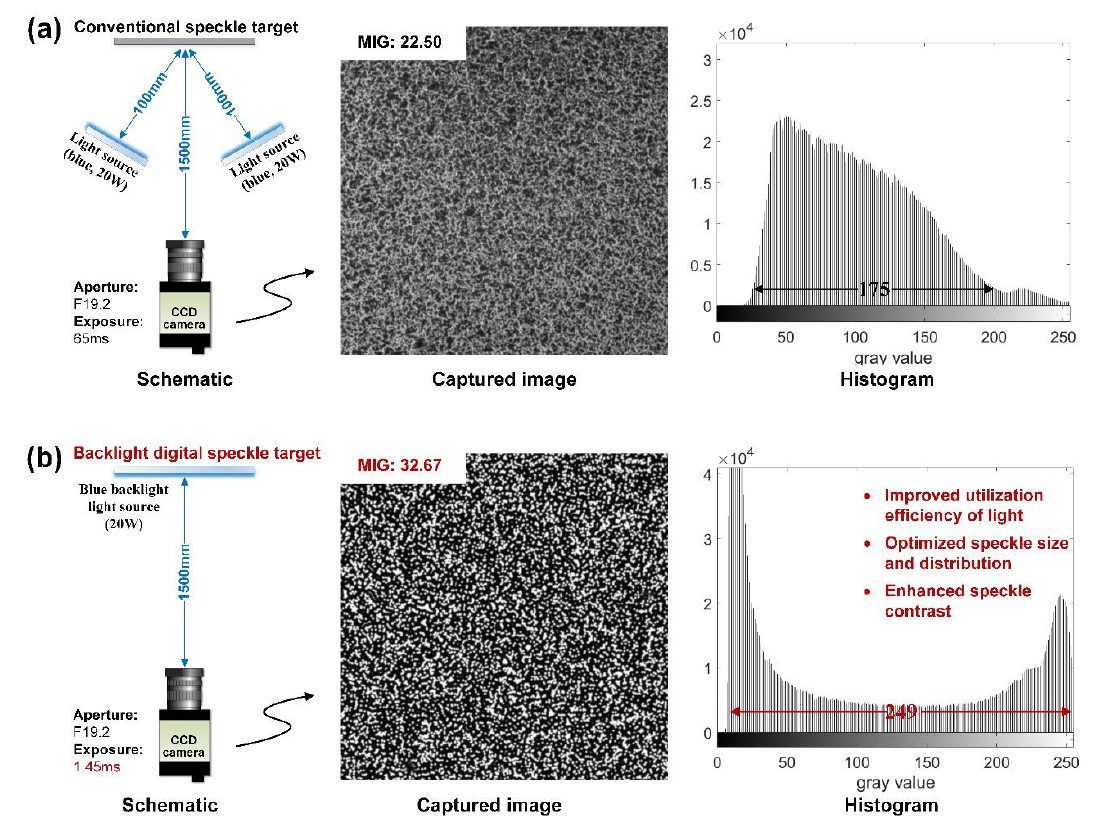
Figure 3. Experimental setups and captured images: ( a ) conventional speckle target; ( b ) backlight digital speckle target.